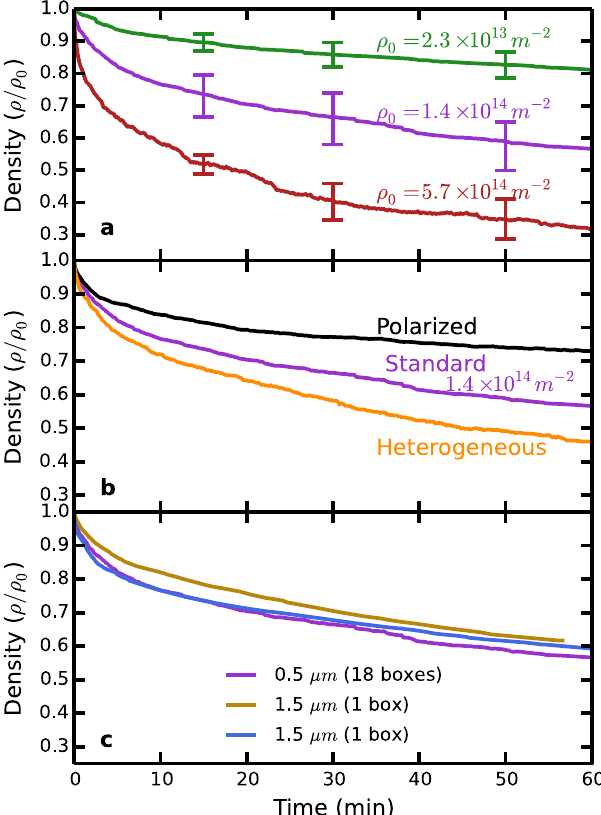
Fig. 6 Differences in averaged dislocation recovery kinetics for networks with different characteristics as summarized in Table 1. a The effect of initial density in standard networks with higher densities resulting in more rapid recovery, b The effect of network structure with polarized networks experiencing slower recovery while the effect of heterogeneity is ambiguous, and c the minimal effect of simulation volume with the average of many small simulations behaving similarly to a single larger simulation. Error bars indicate twice the standard error of the